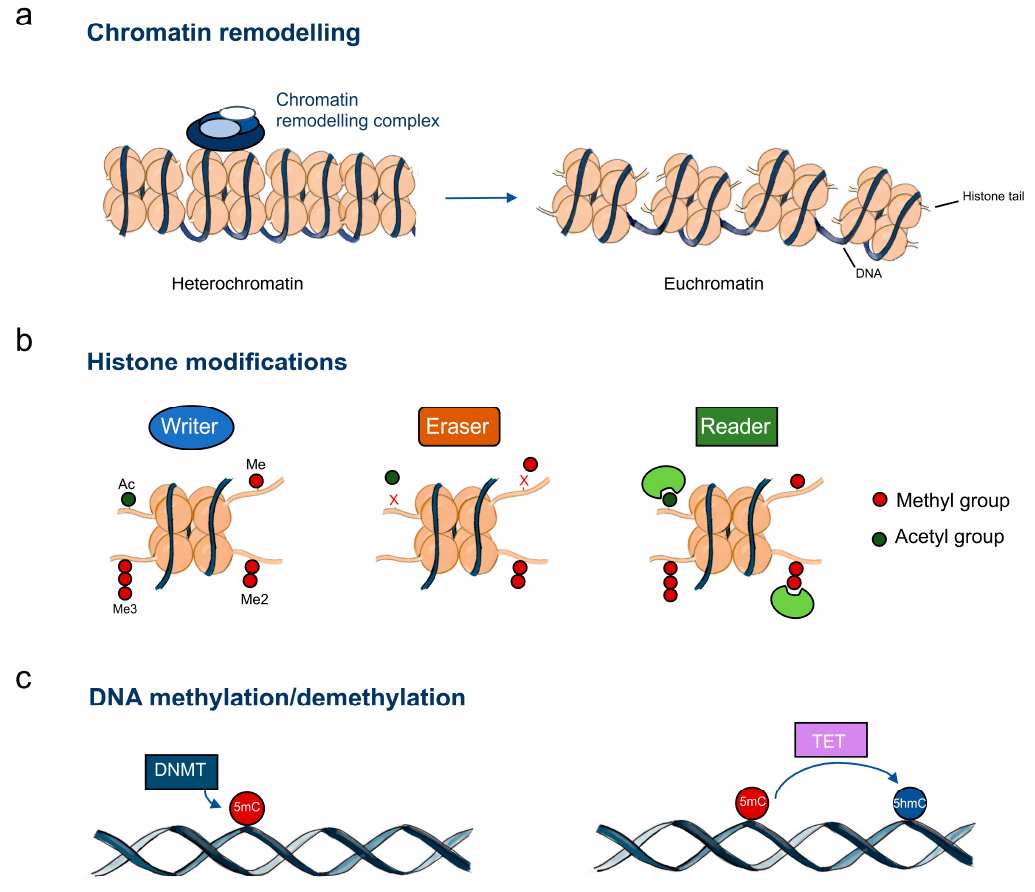
Figure 1. Epigenetic machinery in oesophageal cancer. ( a ) Chromatin-remodelling complexes catalyse chromatin changes including histone and DNA modifications; ( b ) Histone writers, erasers and readers; ( c ) DNA methylation regulators. Abbreviations: Me – methylation; Me2 – dimethylation; Me3